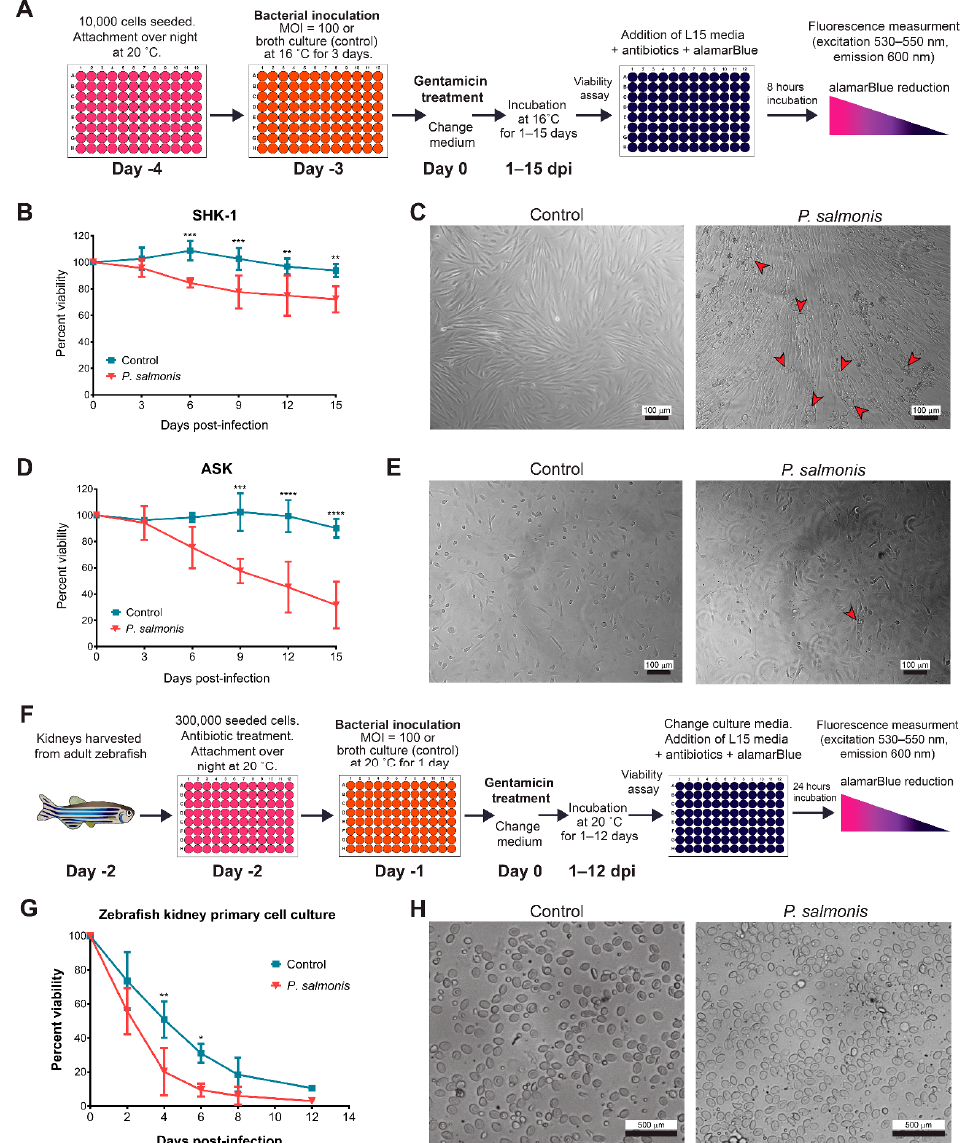
Figure 2. Effect of P. salmonis infection in the viability of SHK-1, ASK and zebrafish primary cell cultures. ( A ) Viability assay and infection protocol for SHK-1 and ASK cell lines. After a three-day incubation period with the bacteria, cultures were washed with fresh media supplemented with gentamicin to kill extracellular bacteria, and the cell viability was monitored over time. SHK-1 ( B ) or ASK ( D ) viability over time measured by alamarBlue, and percent viability (the measured viability of a culture at a given time point relative to the viability of cells at day 0 after gentamicin treatment) is shown in the graphs. An average of three independent assays with six wells each, with the correspondent standard deviation, is shown. Asterisks represent statistically significant differences between control and infected cultures at each time point (** p <0.01, *** p <0.001, **** p < 0.0001). Representative microphotographs of SHK-1 ( C ) or ASK ( E ) cultures 12 dpi with P. salmonis or bacterial culture media as control. Red arrowheads indicate examples of vacuoles. Image with 100 × amplification, bar represents 100 µ m. ( F ) Viability assay and infection protocol for ZKPCC. After 1 day of incubation with the bacteria, the cells were washed with fresh media supplemented with gentamicin to kill extracellular bacteria and the cell viability was monitored over time. ( G ) ZKPCC cell viability over time measured by alamarBlue. Percent viability represents the measured viability of a culture at a given time point relative to the viability of cells at day 0. The average of three independent assays with five wells each, with the correspondent standard deviation, is shown. Asterisks represent statistically significant differences between control and infected cultures at each time point (* p < 0.05, ** p < 0.01). ( H ) Representative microphotographs of ZKPCC at 5 dpi to P. salmonis or bacterial culture media as a control. Image with 400 × amplification, bar represents 500 µ